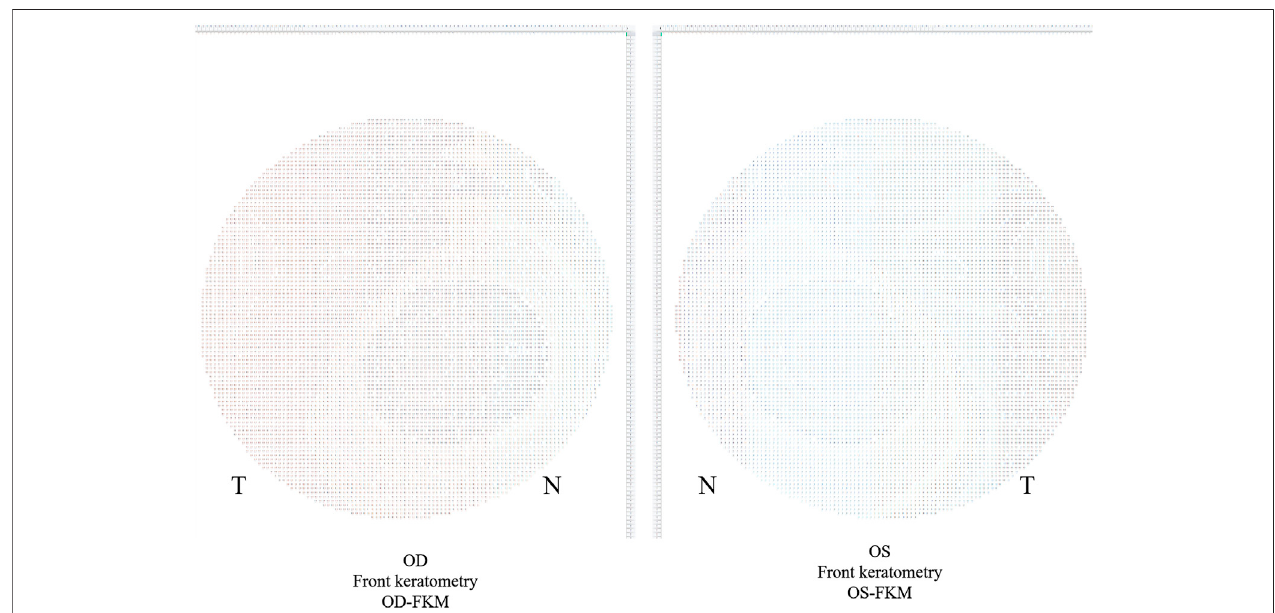
FIGURE 1 | Exported binocular front keratometry matrix (FKM)